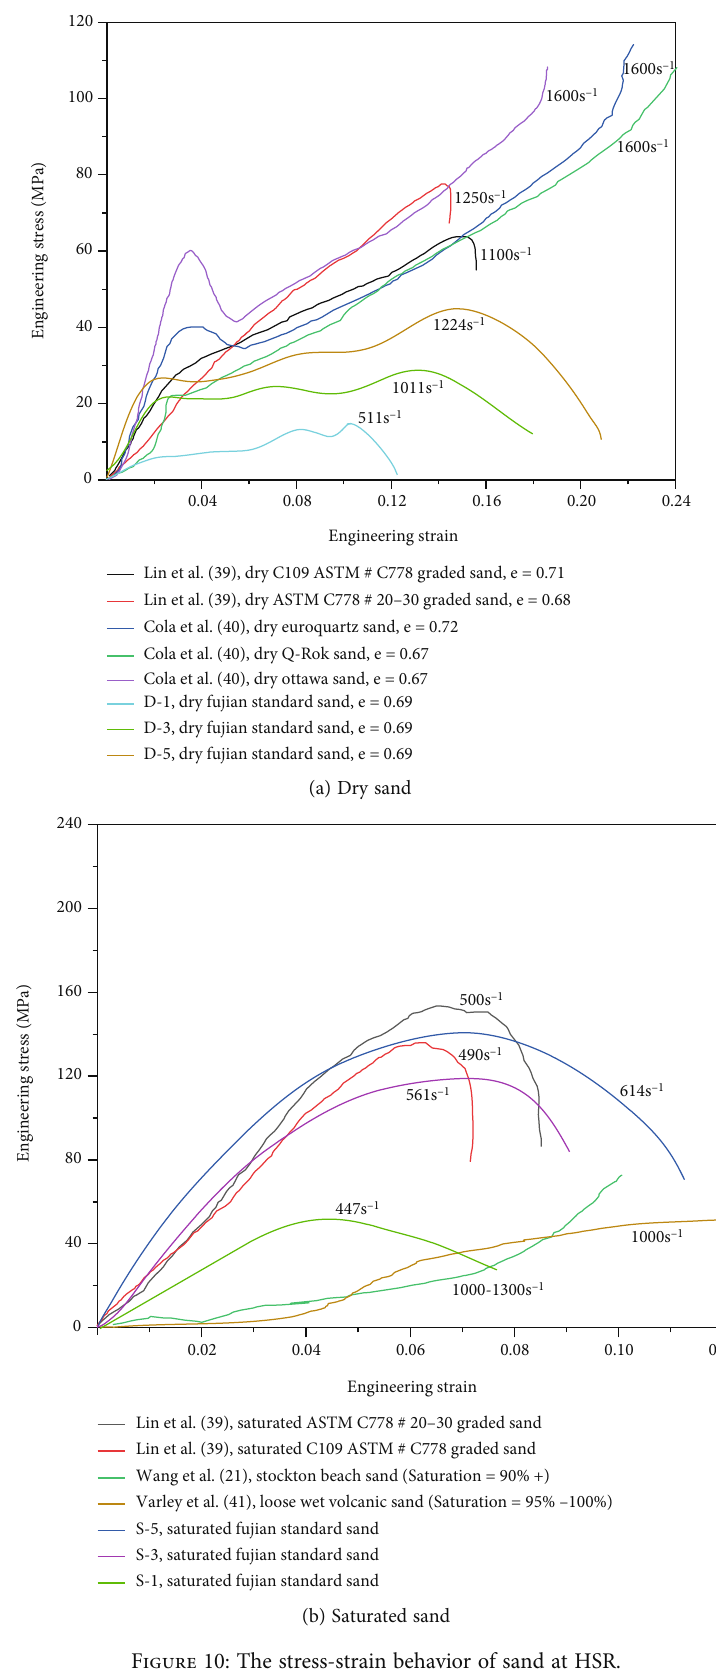
Figure 10: The stress-strain behavior of sand at